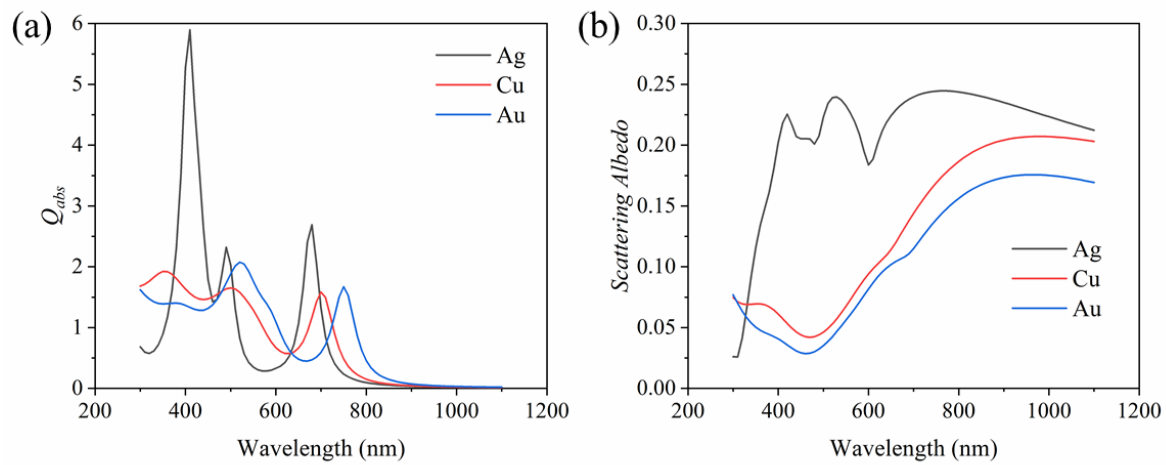
Figure 7. Effects of embedding on ( a ) absorption efficiency and ( b ) scattering albedo of dimer nanoparticle during synthesis (mean of three directions).